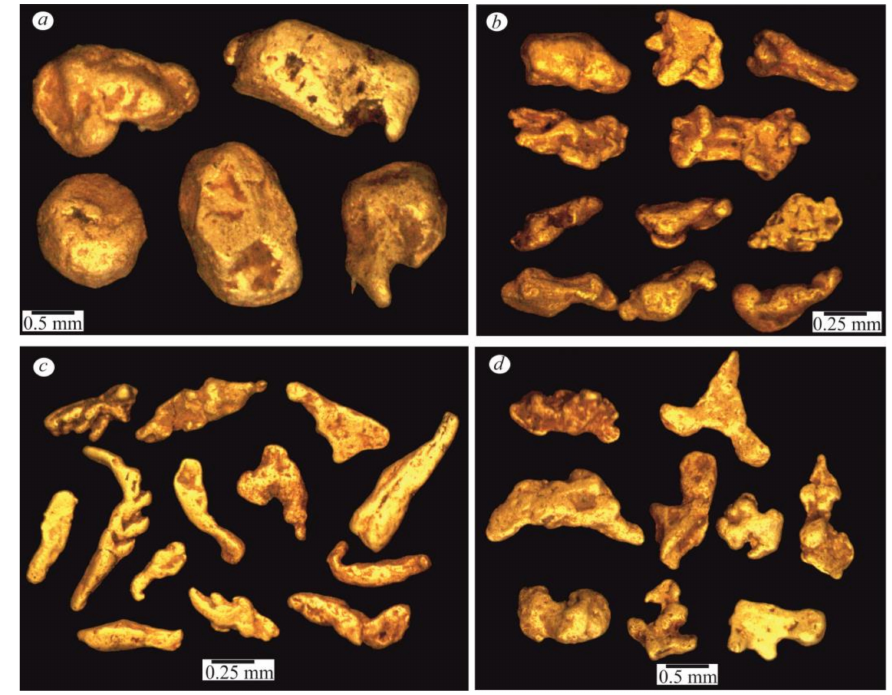
Figure 4. Morphology of placer gold from the Ulakhan Khaptasynnakh Creek: ( a ) subrounded crystals, fractions of 0.5–1 mm; ( b ) poorly rounded cloddy–angular gold, fractions of 0.25–0.5 mm; ( c ) dendritic gold particles, fractions of 0.25–0.5 mm; ( d ) poorly rounded platy gold. Photographed by a Color Digital Camera Levenhuk C800 NG microscope.